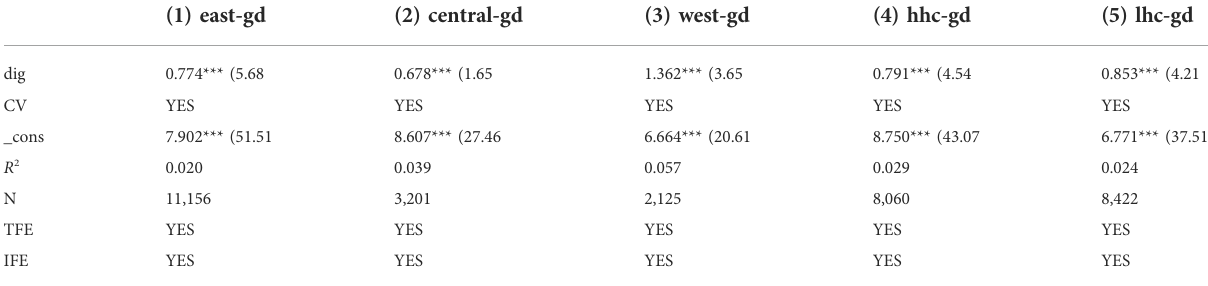
TABLE 6 Heterogeneity test